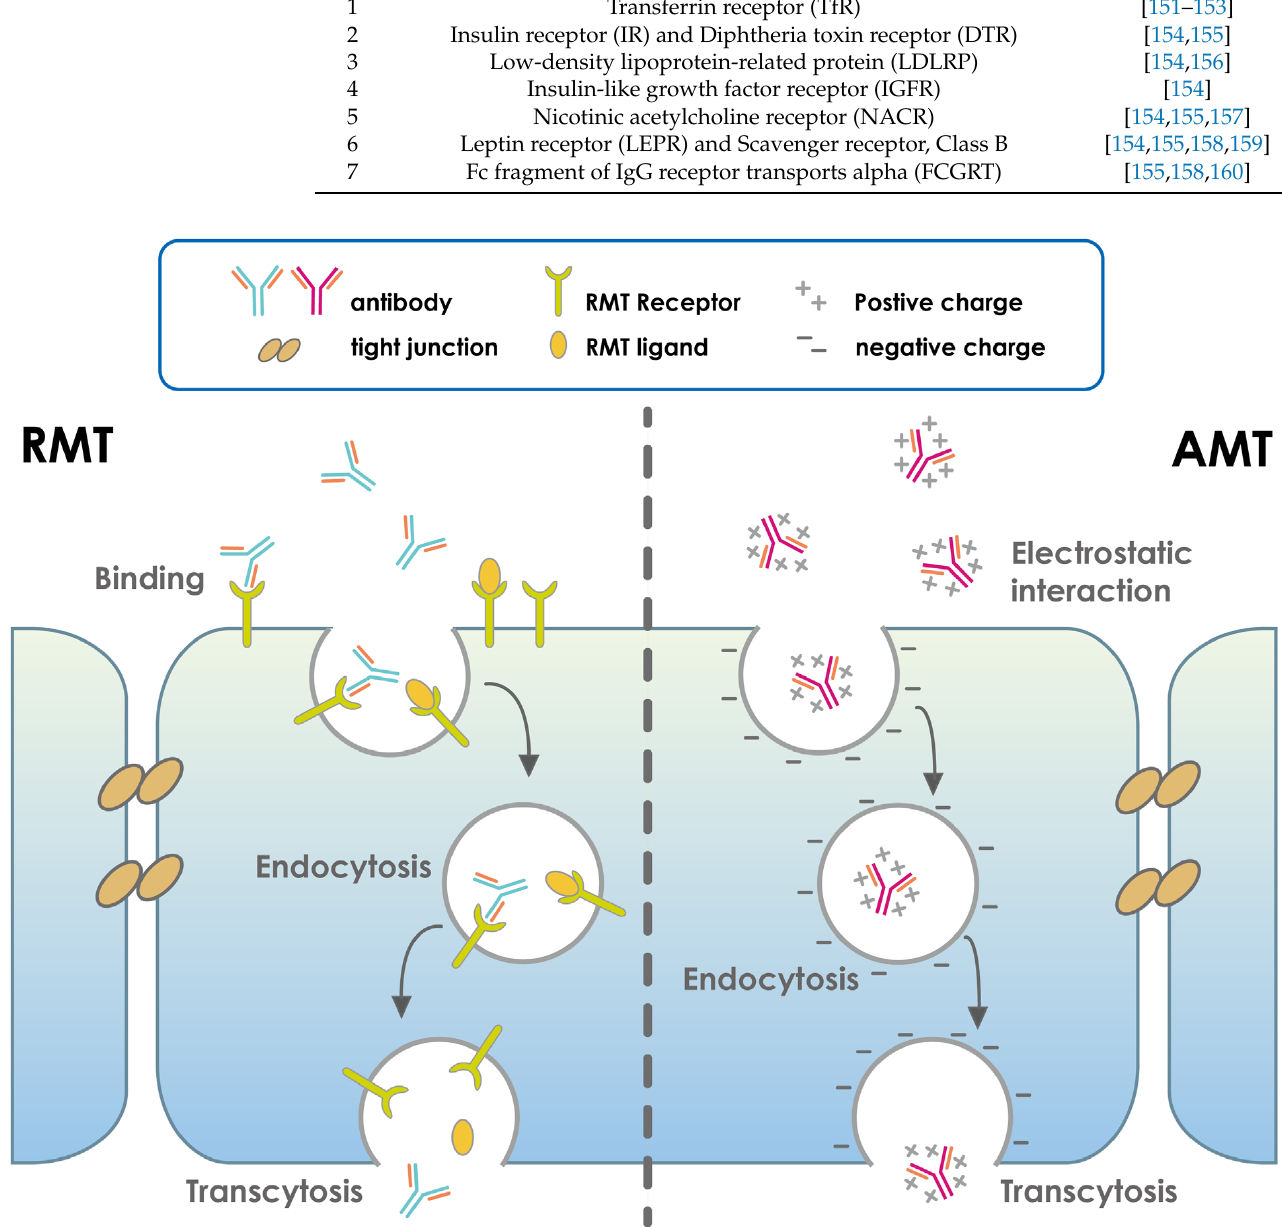
Figure 7. Sketch illustration of the brain’s processes for antibody-based drug transport via the blood–brain barrier. In a receptor-mediated target (RMT), the ligand and antibody in the blood specifically bind to RMT receptors in the apical cell membrane; (2) the receptors and ligands are internalized in an energy-dependent manner to form an intracellular vesicle; and (3) these vesicles are shuttled through the cell cytoplasm, and the antibodies and ligands are released into the brain via the fusion of vesicles with the basolateral cell membrane. In an adsorptive-mediated target (AMT), the positively charged antibodies interact electrostatically with the negatively charged apical cell membrane, forming intracellular vesicles containing antibodies through energy-independent endocytosis. Finally, after traveling through the cell cytoplasm and fusing with the basolateral cell membrane, these vesicles release their contents into the brain.